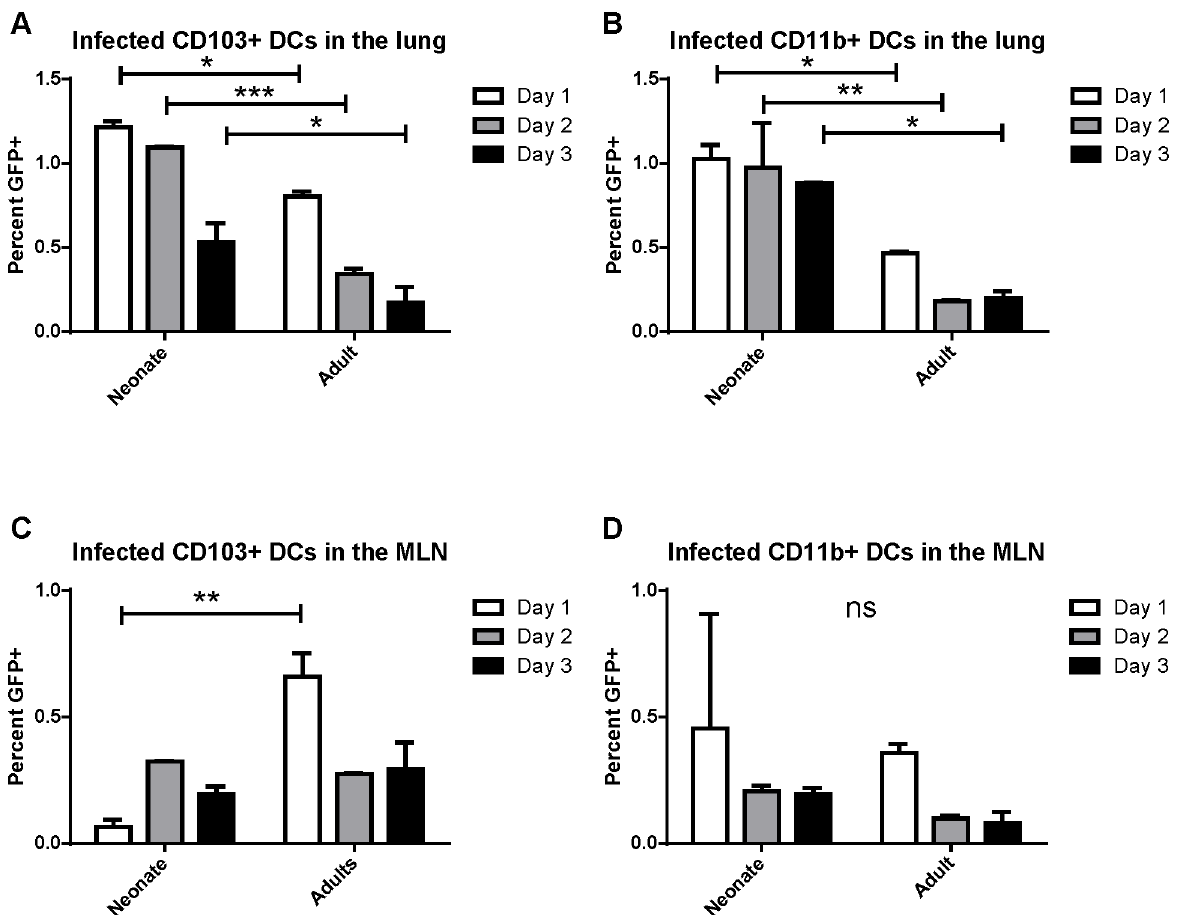
Figure 1. RSV infection of lung migratory dendritic cell populations in the lung and draining mediastinal lymph node. Percent of infected (GFP + ) dendritic cell populations in the lung (A and B) and the posterior mediastinal lymph node (MLN, C and D) at days 1–3 post-infection. Lung and MLN DC populations were gated as described in Figure S1 and S2, respectively. Percent GFP + of CD103 + DCs (A and C) and CD11b + DCs (B and D) was determined by comparison to mice infected at the same time with wtRSV. Data is representative of two experiments done with two pooled samples of 3–7 mice each and the error bars represent the SEM. * p # 0.05, **p # 0.01, ***p # 0.001, ns is no significance by two-way ANOVA and Sidak’s multiple comparisons